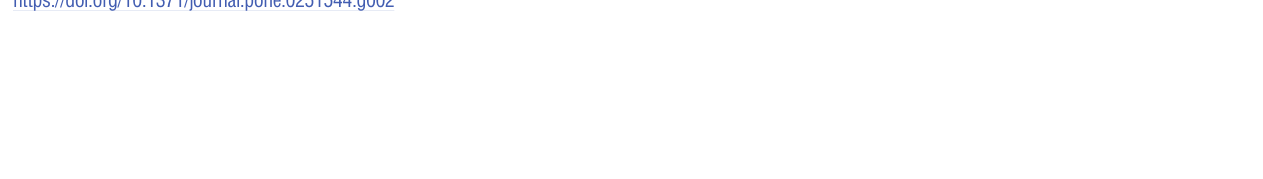
PLOS ONE | https://doi.org/10.1371/journal.pone.0251544 May 13,